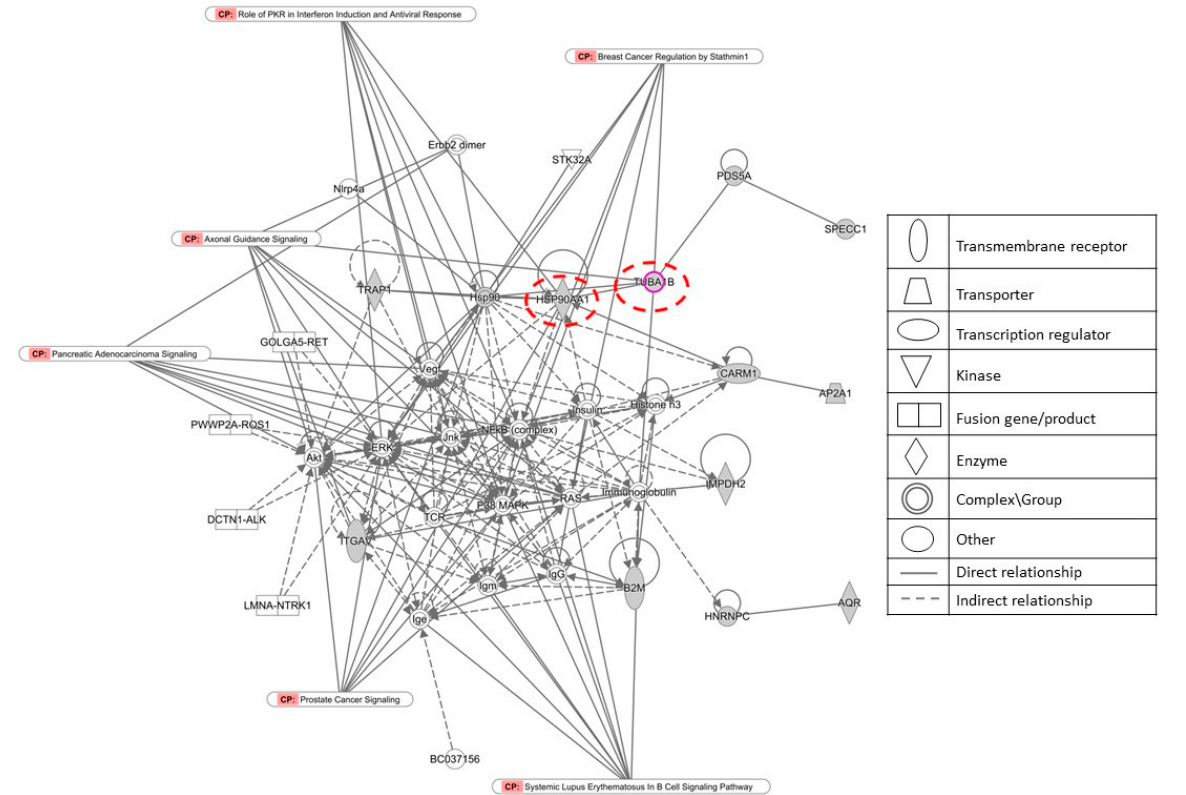
Figure 10. Network analysis using the proteomic data of 40 proteins in a panel of 55 NCT tumor lines and IPA™.